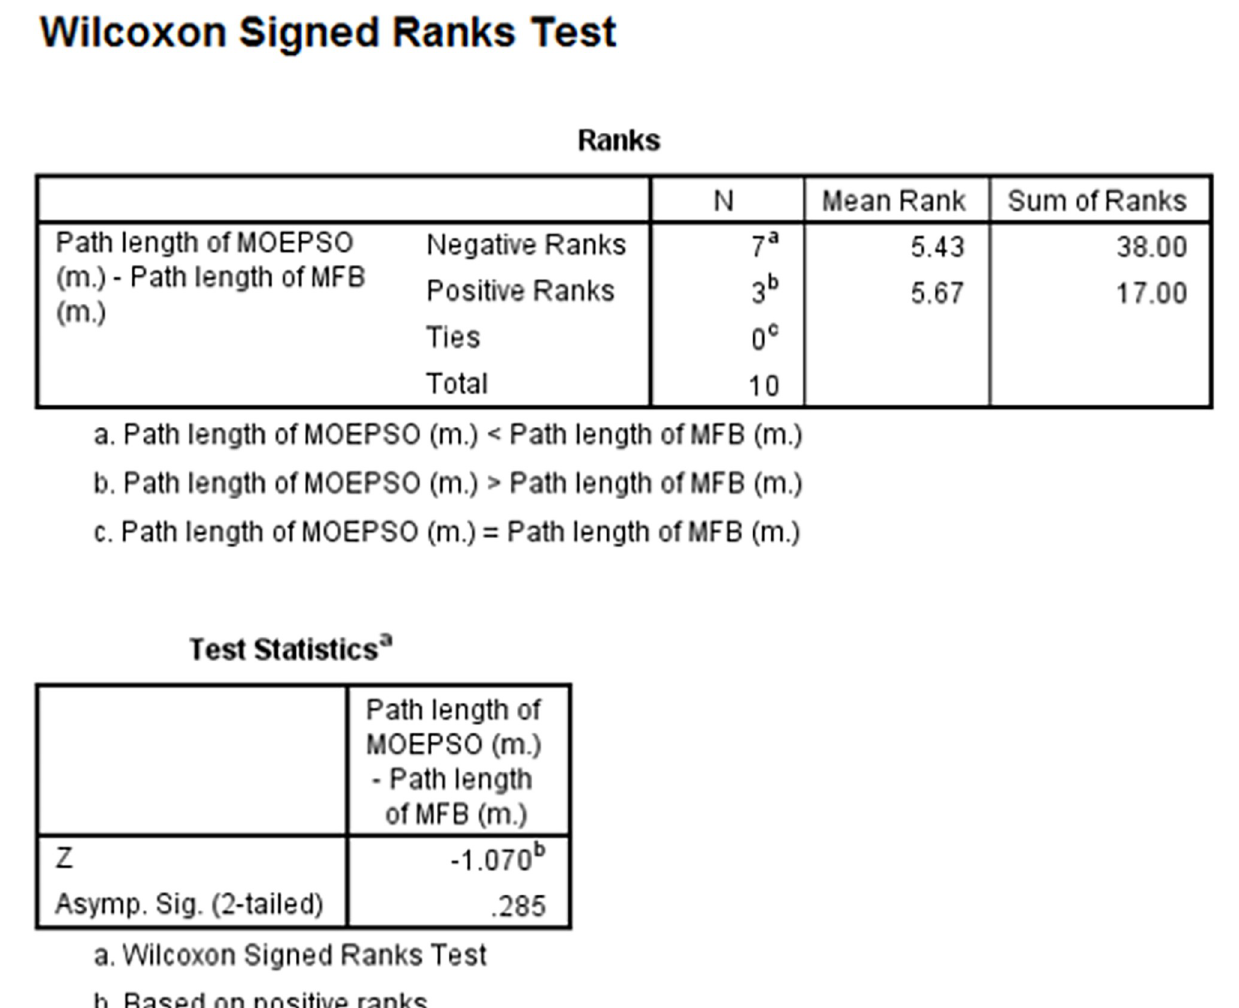
Fig 23. Wilcoxon signed-rank test path length of MOEPSO-path length of